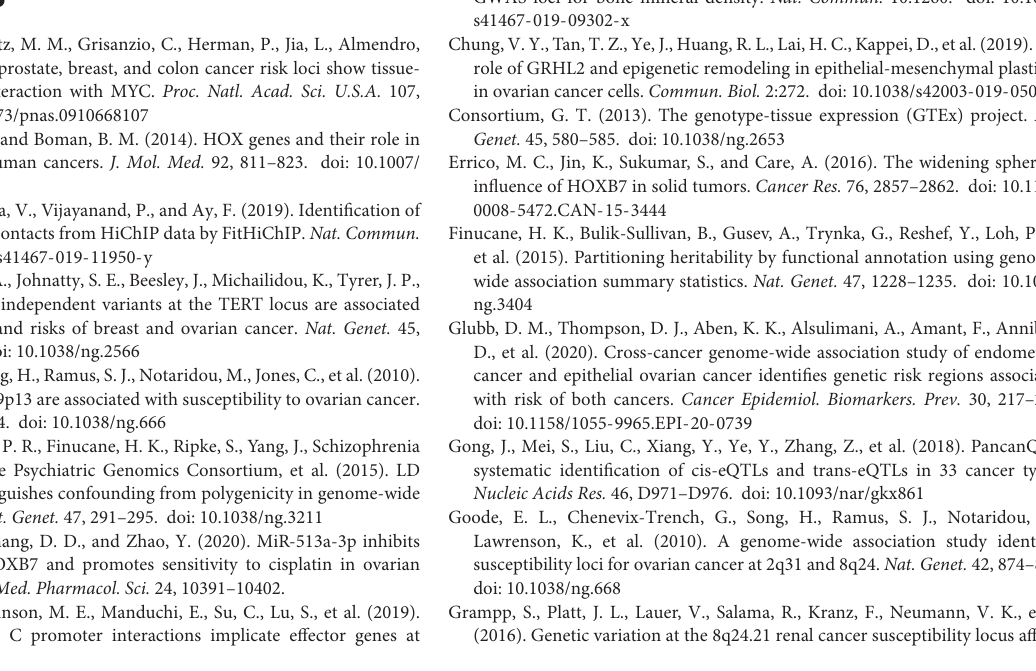
Supplementary Figure 1 | QC of HiChIP results with HiC-pro pipeline and loop calling results with Fit-HiChIP pipeline. Supplementary Figure 2 | General features of Fit-HiChIP identified loops in EOC. Supplementary Figure 3 | Enrichment score of HiChIP target genes calculated by ssGSEA between normal and tumor ovarian samples in three GEO datasets. Supplementary Figure 4 | Expression of SKAP1 expression in SKOV3 and OVCA432 cells after modulating rs9303542 enhancer region. Supplementary Figure 5 | eQTL analysis of HOXB7 and HOXB8 as well as loop profiles of rs8067953. Supplementary Table 1 | HiC-Pro QC results. Supplementary Table 2 | Ninety-nine percent of CVs used in our study. Supplementary Table 3 | Detailed loop information of CVs to target genes in SKOV3. Supplementary Table 4 | Detailed loop information of CVs to target genes in OVCA432. Supplementary Table 5 | Proximal targets and eQTL targets of HiChIP-CVs. Supplementary Table 6 | Detailed information of 39 HiChIP-CVs with ATAC-seq signals in both SKOV3 and OVCA432 cells. Supplementary Table 7 | The primer list used in the